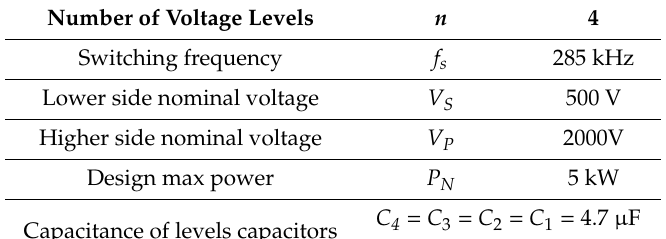
Table 1. Parameters for SiC and Si designs for the base configuration.